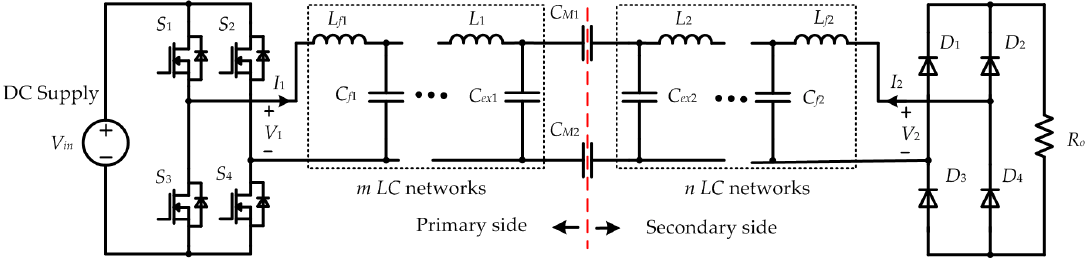
Figure 20. Circuit topology of a CPT system based on full-bridge inverter with m × n LC compensation.